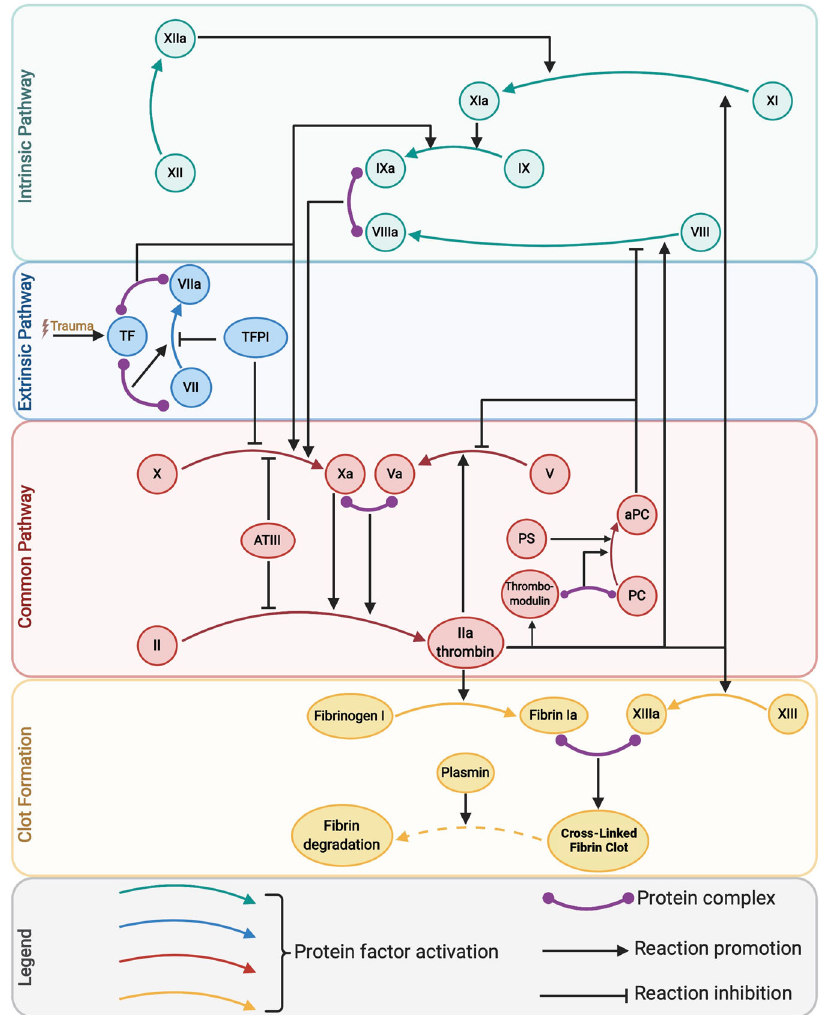
Fig. 2 The coagulation cascade. Details of the plant, i.e., patient clotting dynamics, as embodied by the coagulation cascade, which consists of biochemical reactions that are initiated following injury. The release of tissue factor (TF) drives the process to generate thrombin, a key end product. Most of the involved proteins, called coagulation factors, are denoted by Roman numerals. An added letter “ a ” indicates activation. Anticoagulant proteins include tissue factor pathway inhibitor (TFPI), antithrombin (ATIII), protein C (PC), and protein S (PS). Created with